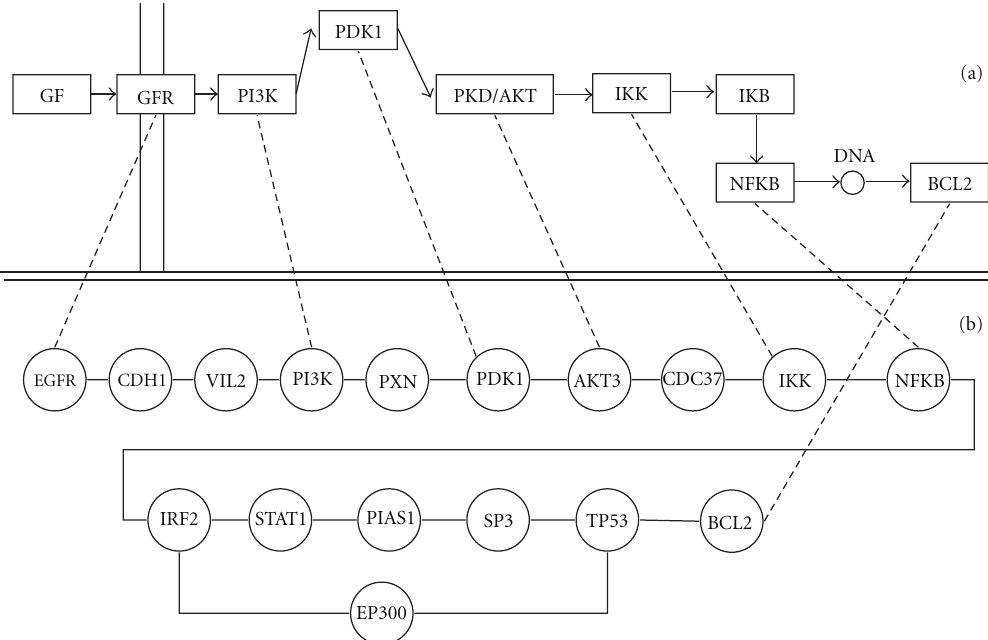
Figure 8: (a) One of the KEGG prostate cancer pathways (b) the paths detected by our method. The dash line means the mapping genes. is faster than Scott color-coding method and we are able to detect the length of paths above 10 within 29 seconds while